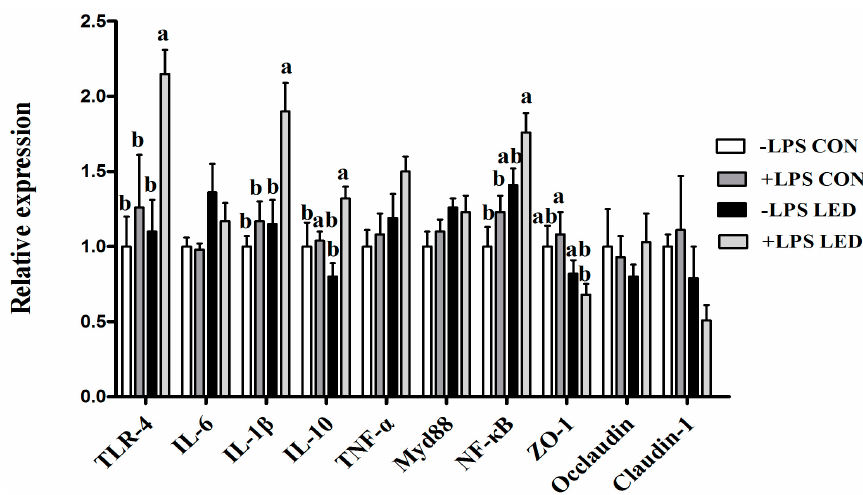
Figure 3. Effect of different energy level during gestation on immune related genes of weaned piglets challenged with Escherichia coli lipopolysaccharide. TLR-4 , Toll-like receptor 4; IL , interleukin; MyD88 , myeloid differentiation factor 88; NF- κ B , nuclear factor kappa B; TNF- α , tumor necrosis factor α . Values are expressed as mean values with their standard errors; means with different superscript letters are significantly different ( p < 0.05); the replicated number of each group is 6.